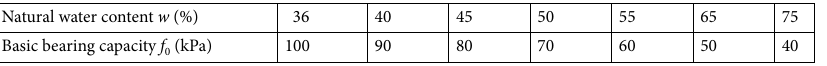
Table 1. Basic bearing capacity of the soft soil foundation.